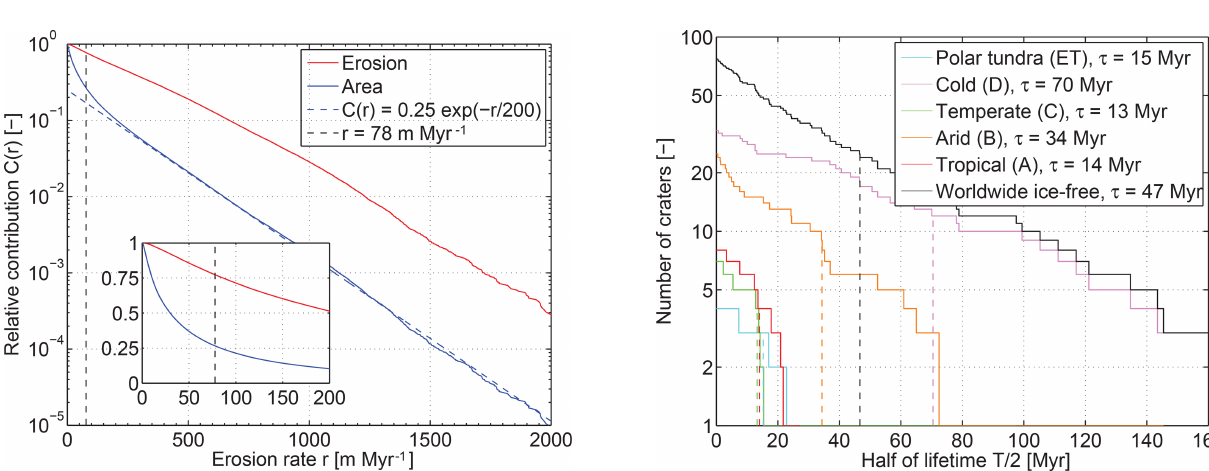
Figure 7. Cumulative number of the considered craters as a func- tion of half of their estimated lifetime, equivalent to the sensitivity of the number of craters to changes in the erosion rate at a given time. The values of τ given in the legend are the decay constants of the exponential